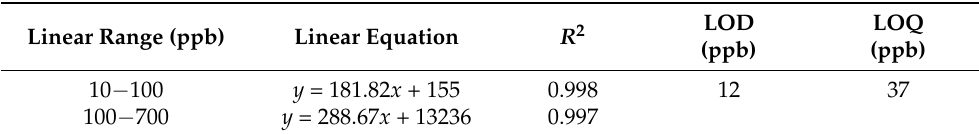
Table 1. The analytical properties of the chromatographic method for the determination of resveratrol using UHPLC-FD.